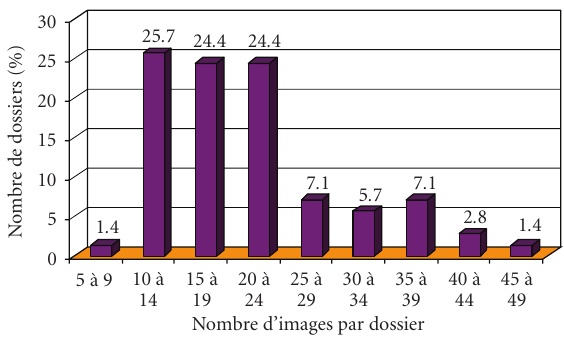
Figure 4: Distribution of the number of images per